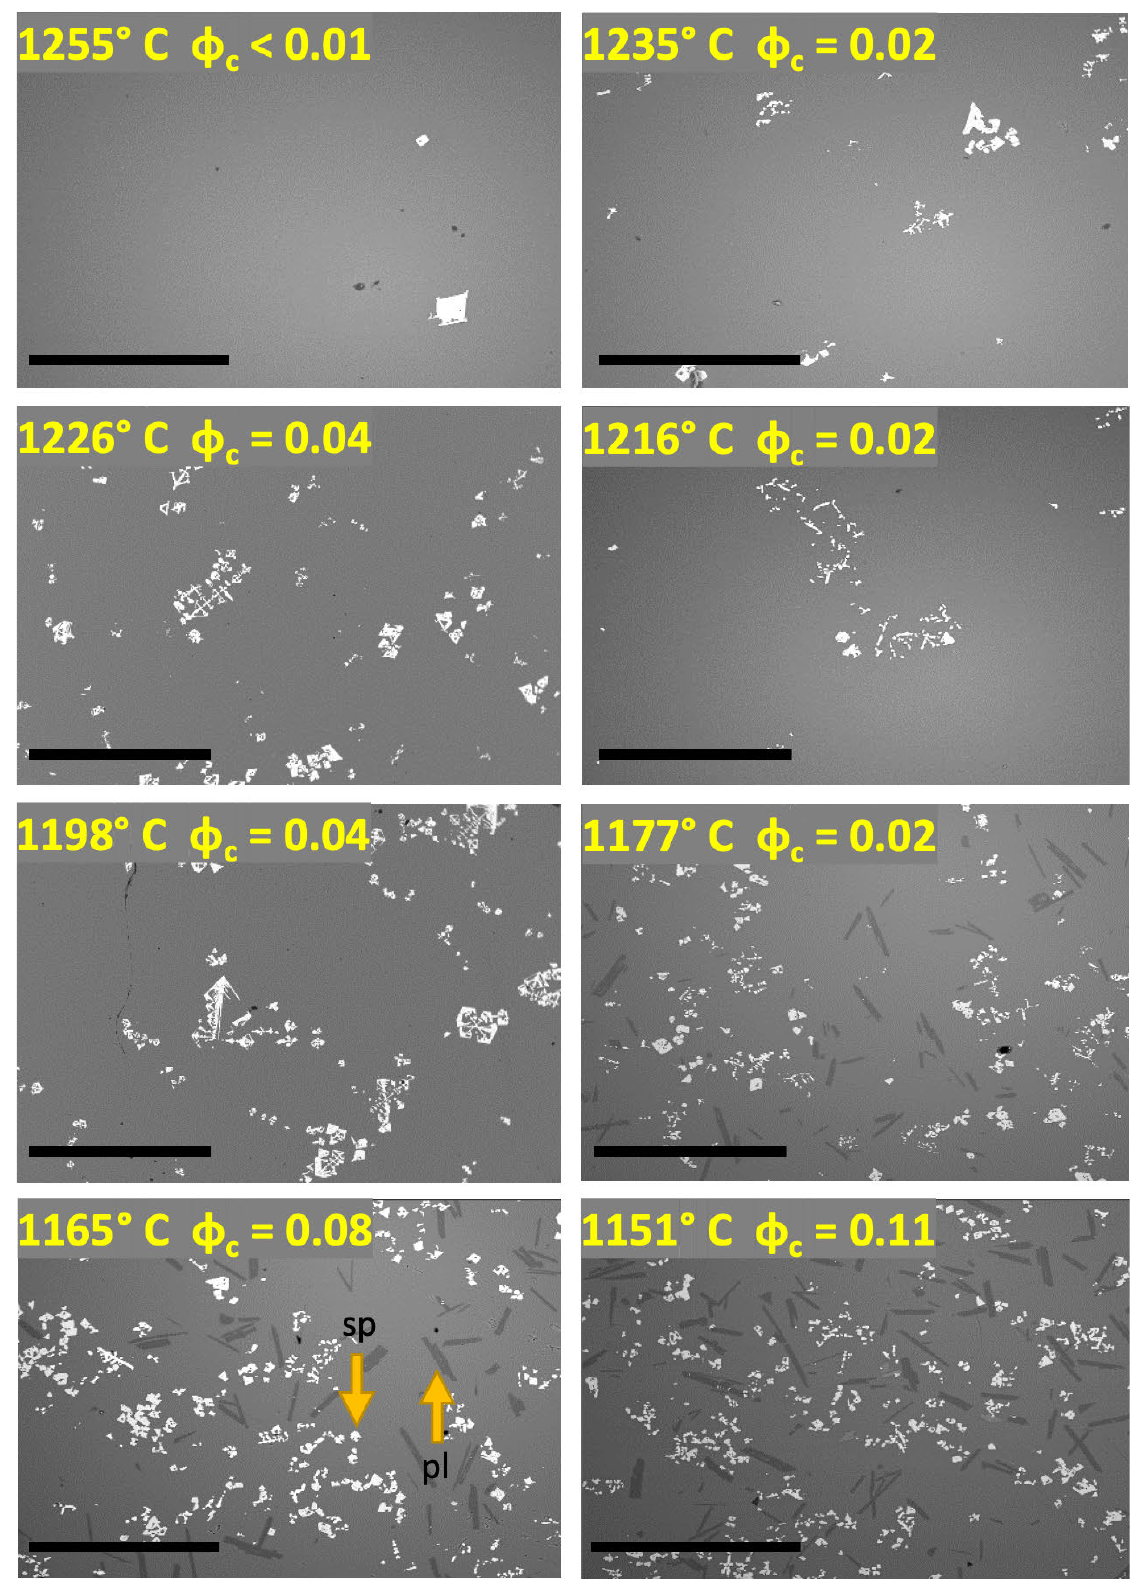
Figure 4: Backscattered electron images of each subliquidus experiment for Nyamuragira (NYA-1948). The black scale bar in each image is 500 µm. Crystal fraction uncertainty is roughly ± 0.02 (see Table 2). White crystals are spinels (sp) and dark gray crystals are plagioclase